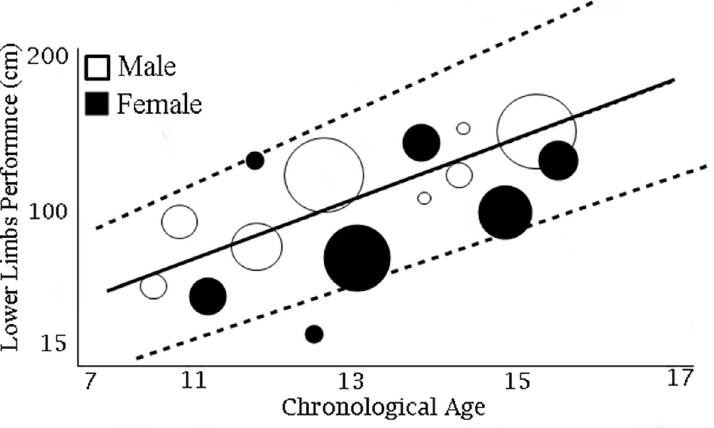
Fig 4. Meta-regression analyses to verify the relationship of chronological age with lower limbs performance. (cm): Centimeters. —-: Confidence Interval 95%.